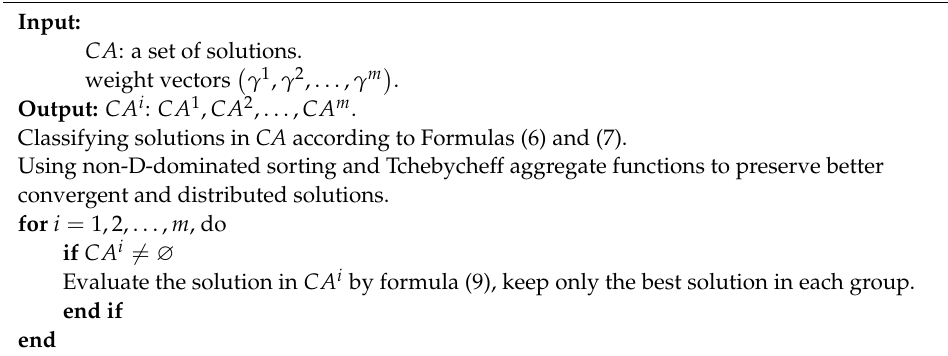
Algorithm 2: Determine the convergence archive